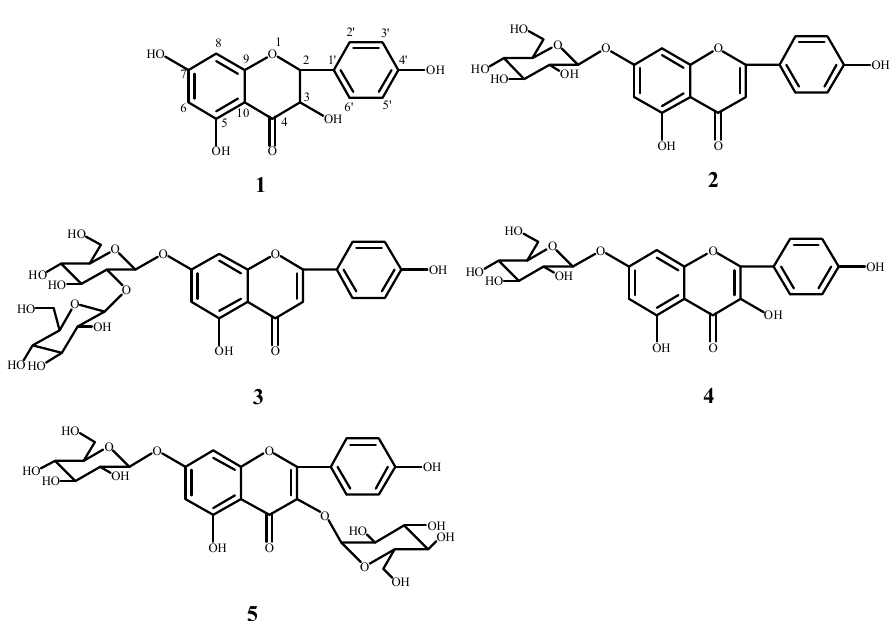
Figure 3. The structures of compounds: 1 – 5 (dihydrokaempferol ( 1 ); apigenin-7- O - β - D -glucoside ( 2 ); apigenin-7- O - β - D -neohesperidoside ( 3 ); kaempferol-7- O - β - D -glucopyranoside ( 4 ); kaempferol-3- O - β - D -glucopyranosyl-7- O - β - D -glucopyranoside ( 5 )).